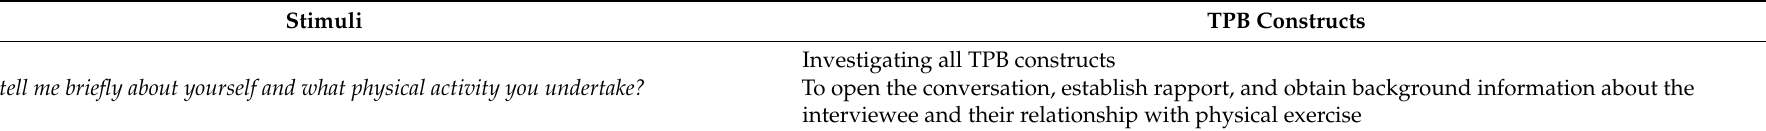
Table A1. Unhealthy supplement usage semi-structured interview